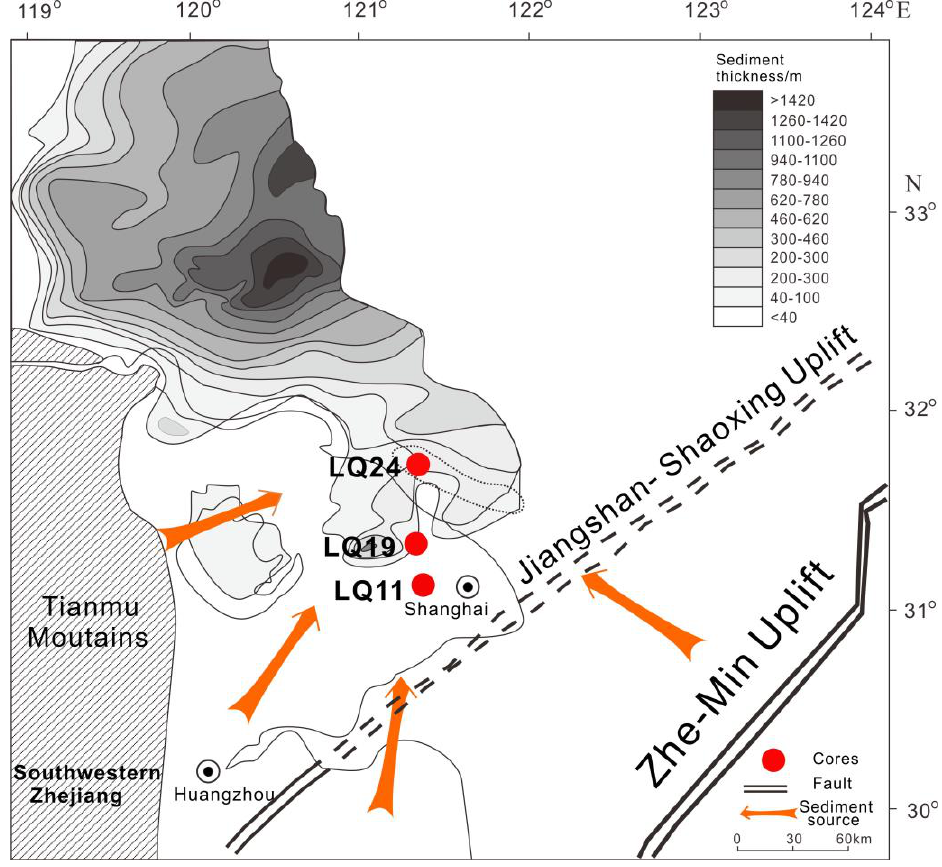
Figure 8. Sediment sources of the Yangtze Delta in the Pliocene. The contours of the sediment were modified after [45].